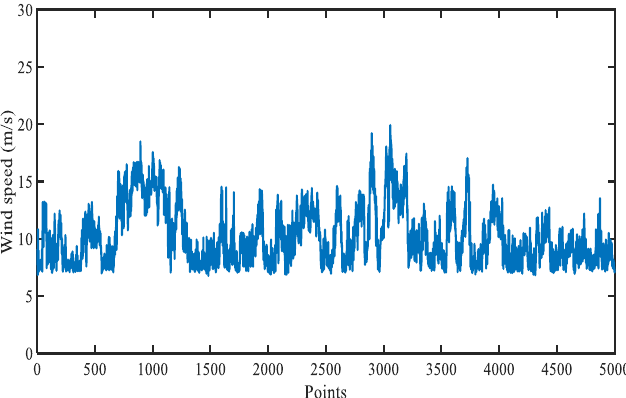
Figure 13. Actual wind speed of the wind turbine.